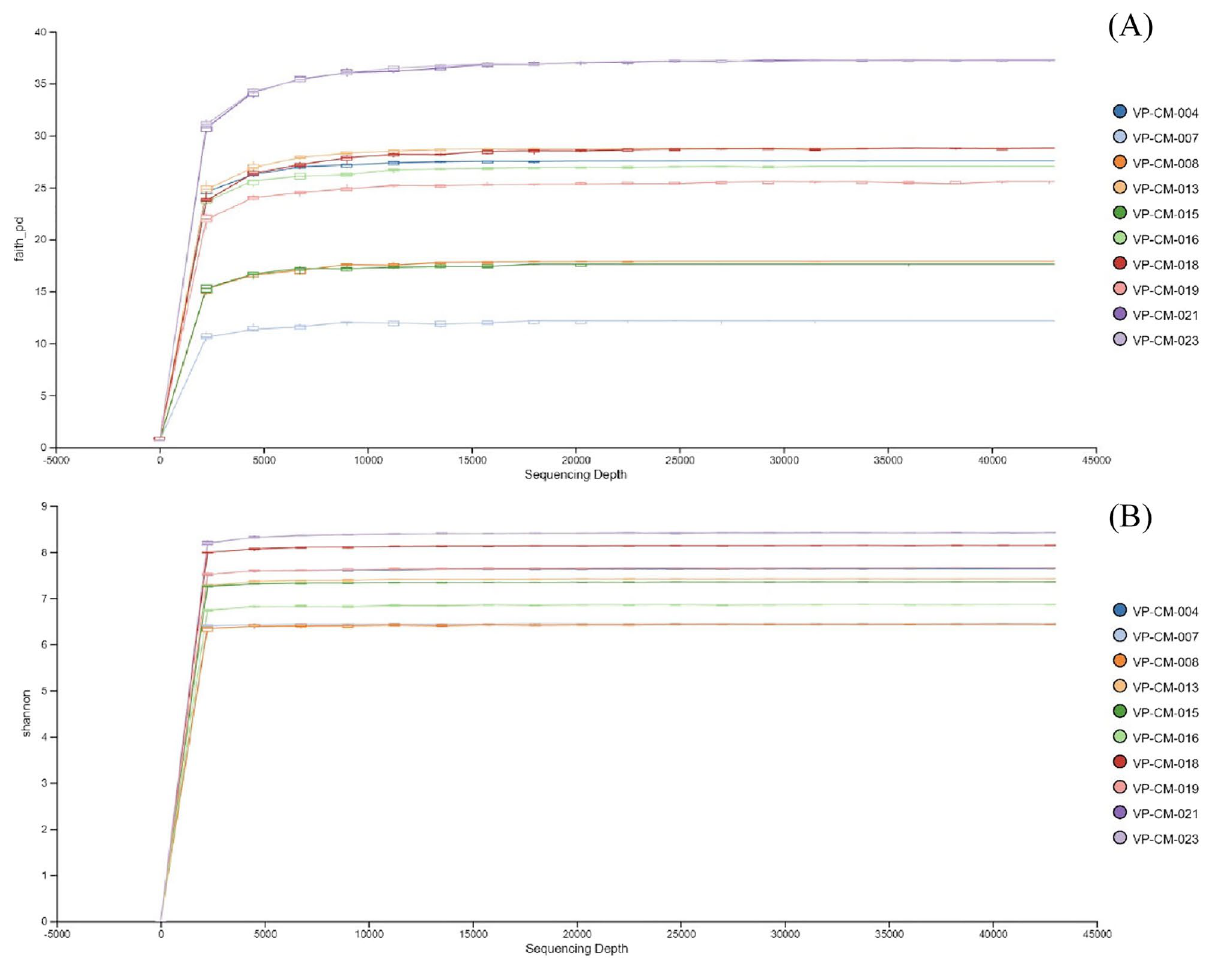
Figure 1. Rarefaction curve showing the bacterial species richness observed from 10 lichen samples, estimated with ( A ) Faith’s PD metric and ( B ) Shannon metric